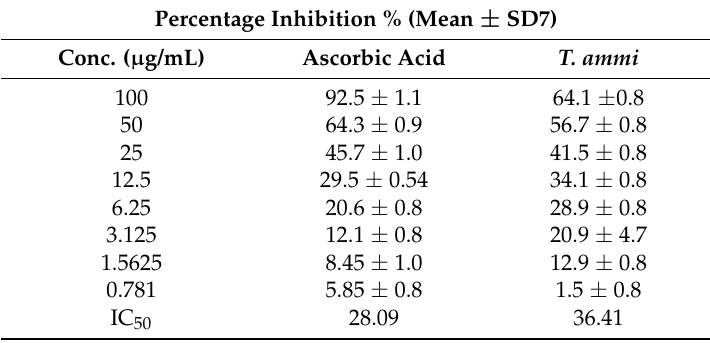
Table 7. Summary of % inhibition and IC 50 values of the T. ammi oil sample by the DPPH method ( n =